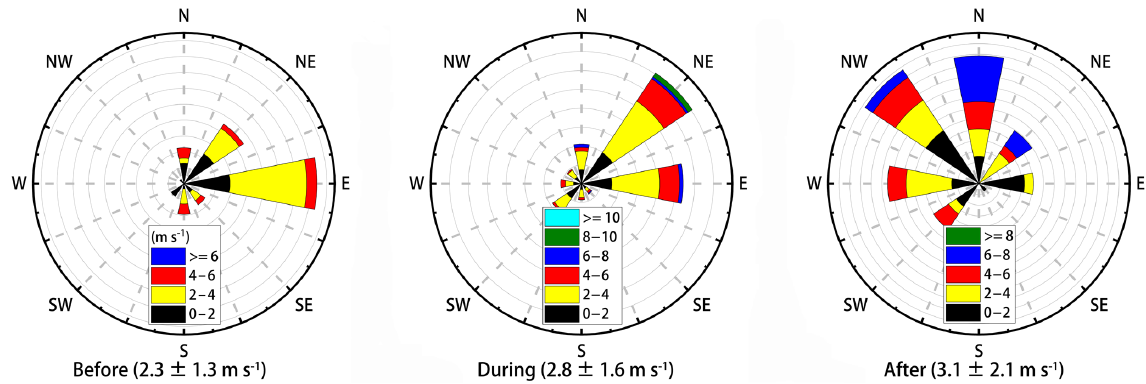
Figure 11. Wind roses for the periods before, during and after the 12 precipitation events. The average wind speed ( ± 1 σ ) for each period is shown in